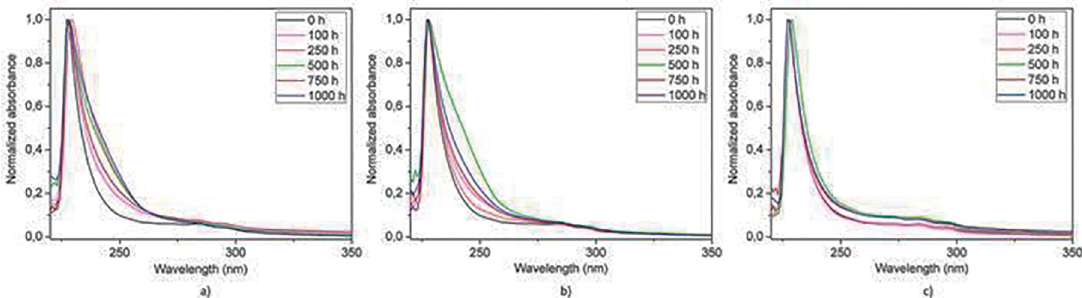
Figure 4. UV-Vis spectra for LC in 9.5x10-3 M CH2Cl2 solution according to the exposure time: a) exposure in UV-A radiation chamber with cooling; b) exposure in UV-A and UV-B radiation chamber without cooling; c) exposure in thermal